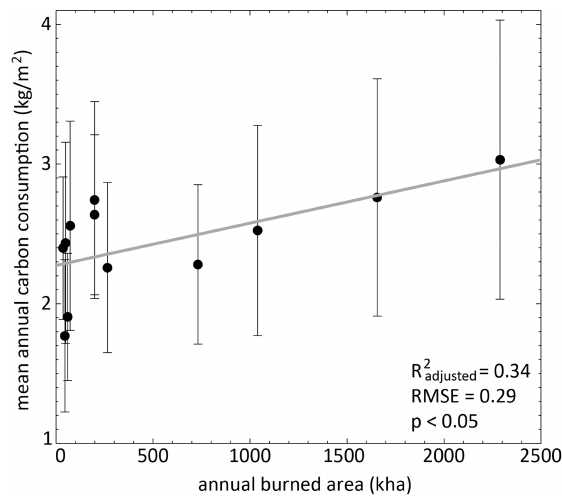
Figure 8. Relationship between annual burned area and mean an- nual carbon consumption. The error bars represent 1 standard devi- ation.